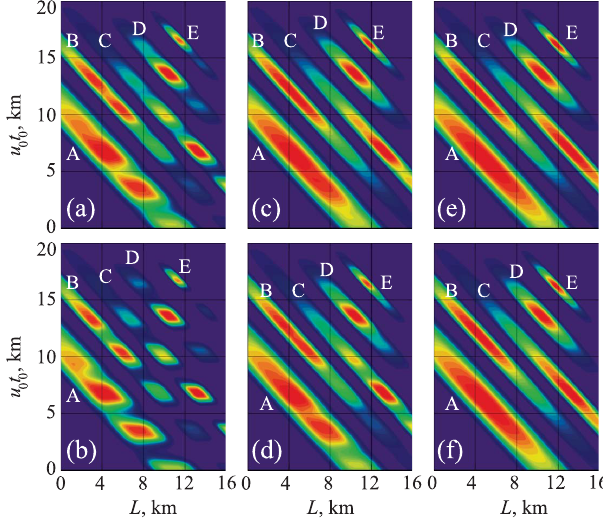
Figure 5. The impact of measurement direction fluctuations on the lidar image J A of aerosol clusters. The pseudo-colored scale of J A values is the same as in Fig. 3. Oscillation amplitudes: (a, c, e) ϕ 0 = 0 . 3 ◦ ; (b, d, f) ϕ 0 = 0 . 6 ◦ . Vertical dimensions: (a, b) δo = 50m; (c, d) δo = 150m; (e, f) δo =